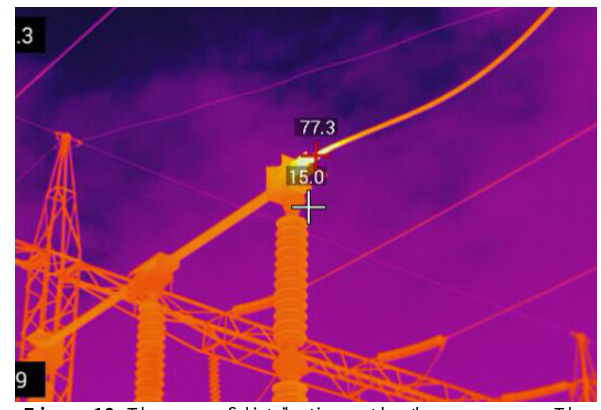
Figure 19. The snap of distribution net by thermo camera. The temperature 77.3 and 15 is reading in C o .